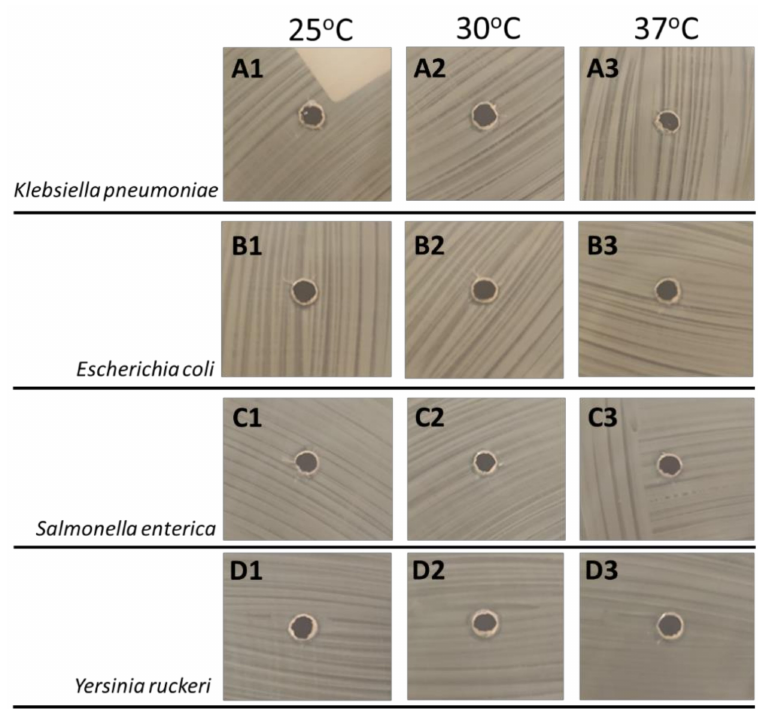
Figure 3. Lack of inhibition of fish and foodborne bacterial pathogens cultured overnight on Mueller– Hinton agar plates at 25 ◦ C, 30 ◦ C and 37 ◦ C., Klebsiella pneumoniae ( A1 – A3 ), Escherichia coli ( B1 – B3 ), and Salmonella enterica ( C1 – C3 ) Yersinia ruckeri ( D1 – D3 ) showing no inhibition at 33 µ g/mL GarKS after overnight culture on Mueller–Hinton agar plates at 25 ◦ C, 30 ◦ C and 37 ◦